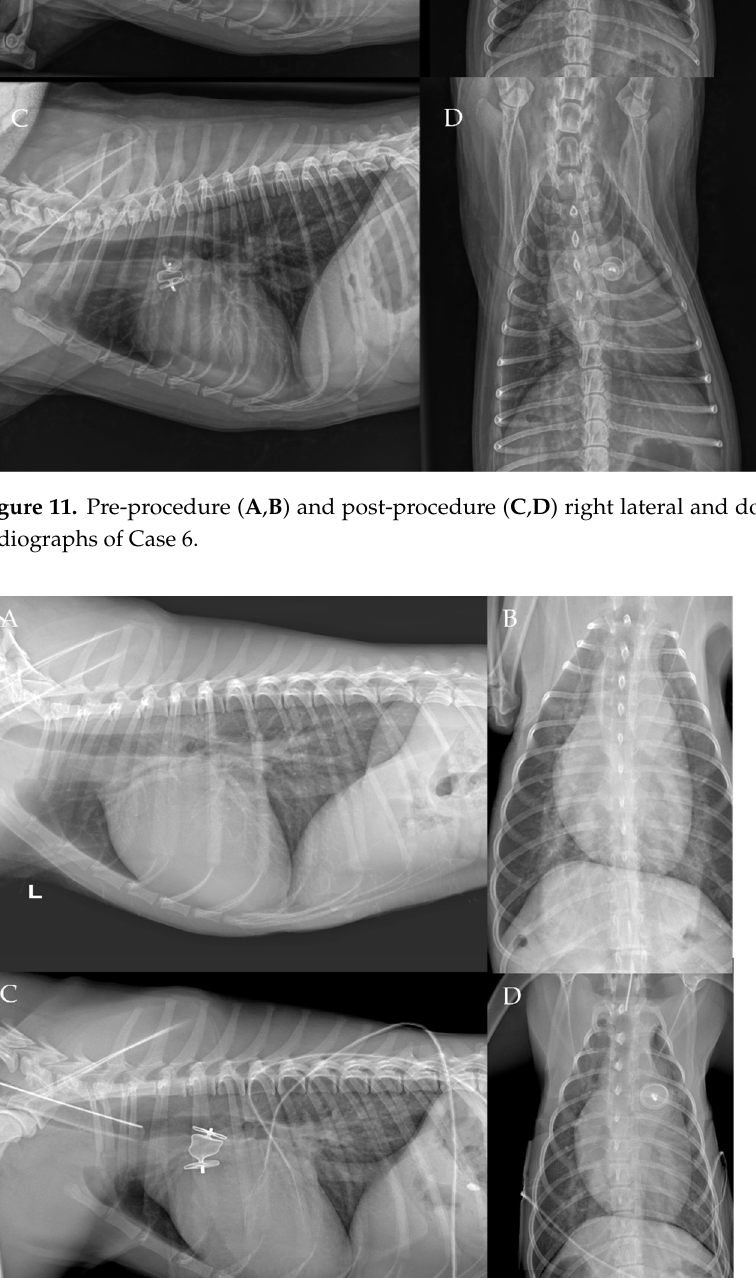
Figure 12. Pre-procedure ( A , B ) and post-procedure ( C , D ) right and left lateral and dorso-ventral thoracic radiographs of Case 7. L: left; R: right.